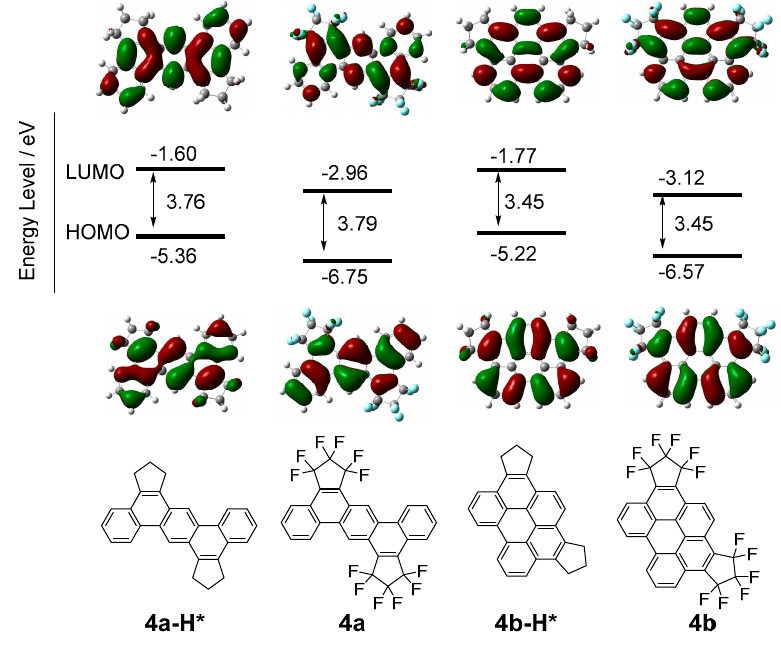
Figure 3. Molecular orbital diagram for fluorine-containing PAHs (F-PAHs) ( 4a and 4b ) and their corresponding PAH ( 4a-H* and 4b-H* ), in which all fluorine atoms in 4a and 4b are replaced with hydrogen atoms.